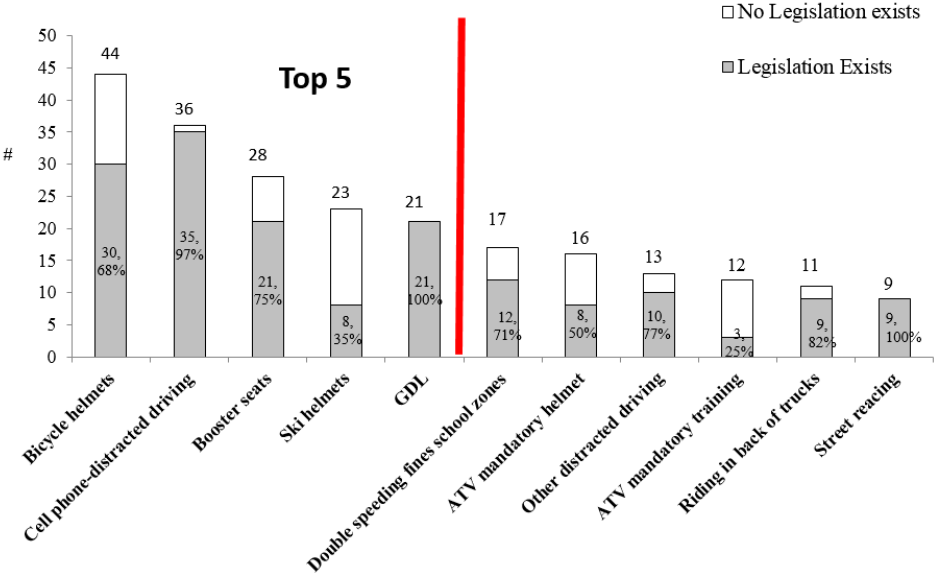
Figure 2. Top five topics and existing provincial legislation.